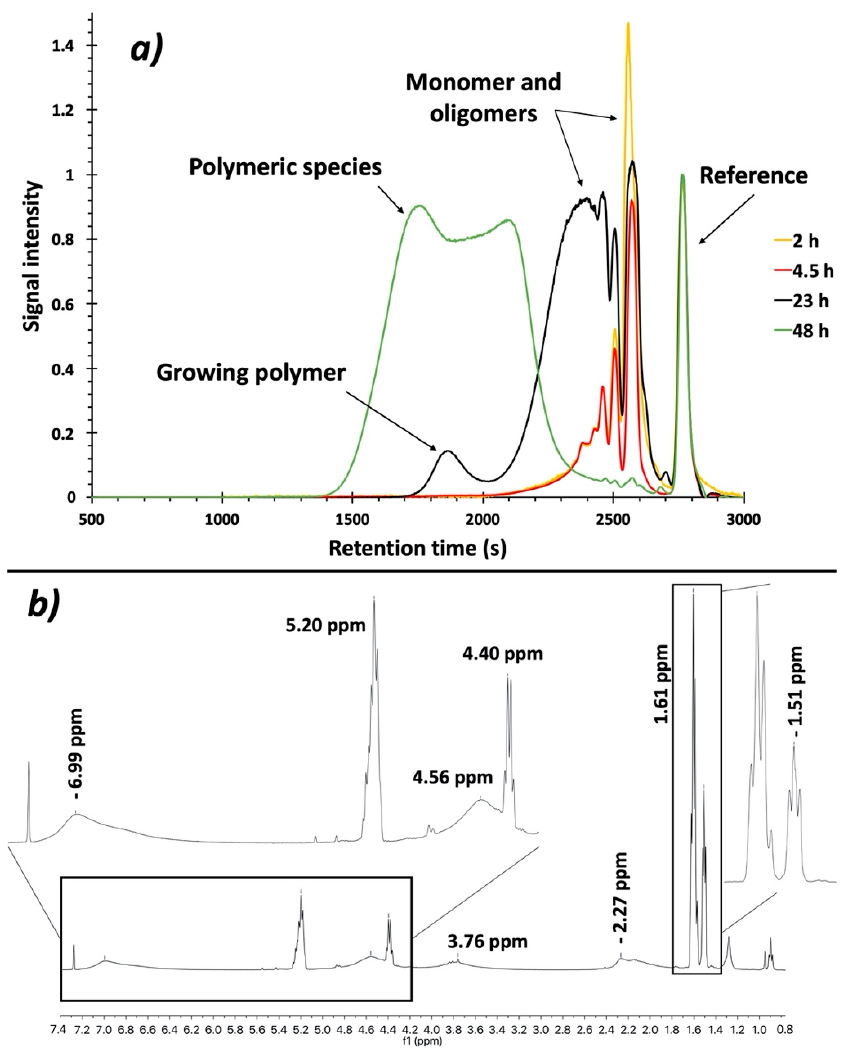
Figure 2. ( a ) SEC chromatograms of samples taken from the MeDOX polymerization reaction. ( b ) 1 H NMR spectrum of the MeDOX polymerization product.